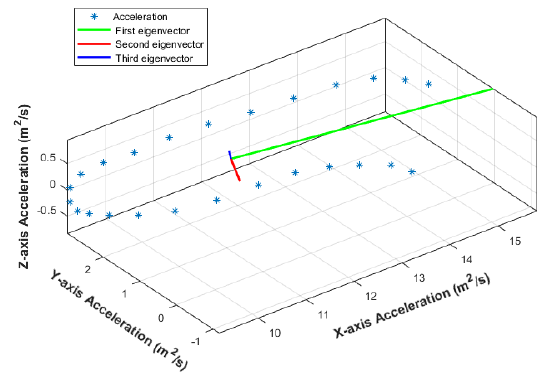
Figure 9. The eigenvectors extraction for Swinging Next, the R-vector is plotted on the horizontal plane according to Equation 11 using the gravitational vector (Mizell 2003).